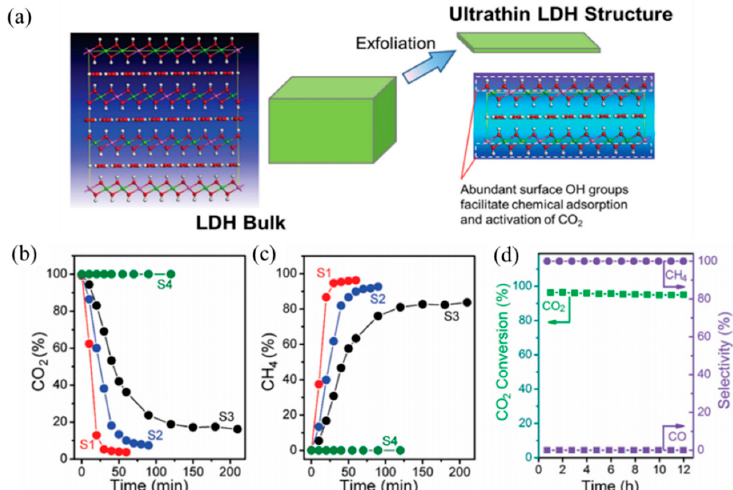
Figure 3. ( a ) Schematic presence of the formation of the ultrathin LDH structure and ( b – d ) the catalytic performance of Ru@FL-LDHs [64]. Table 2. Catalytic performance of CO 2 methanation for different catalysts in different works.